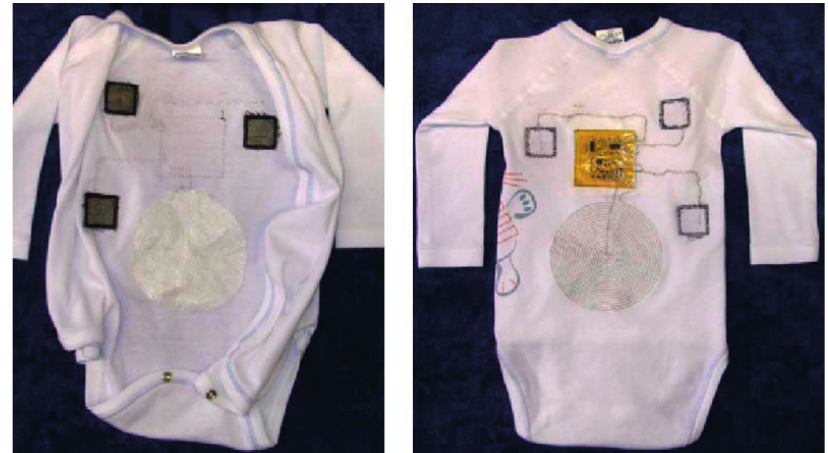
Figure 15. Baby suit prototype for ECG measurement. ( Left ) inside showing the Textrodes; ( right ) outside [31]. Copyright © 2005 Elsevier